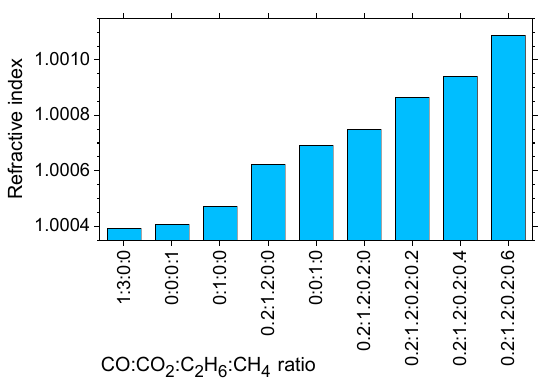
Figure 25. Refractive indices (mean over 0.3–1.3 THz) of natural gas constituents and their different mixes. Adapted from [181].